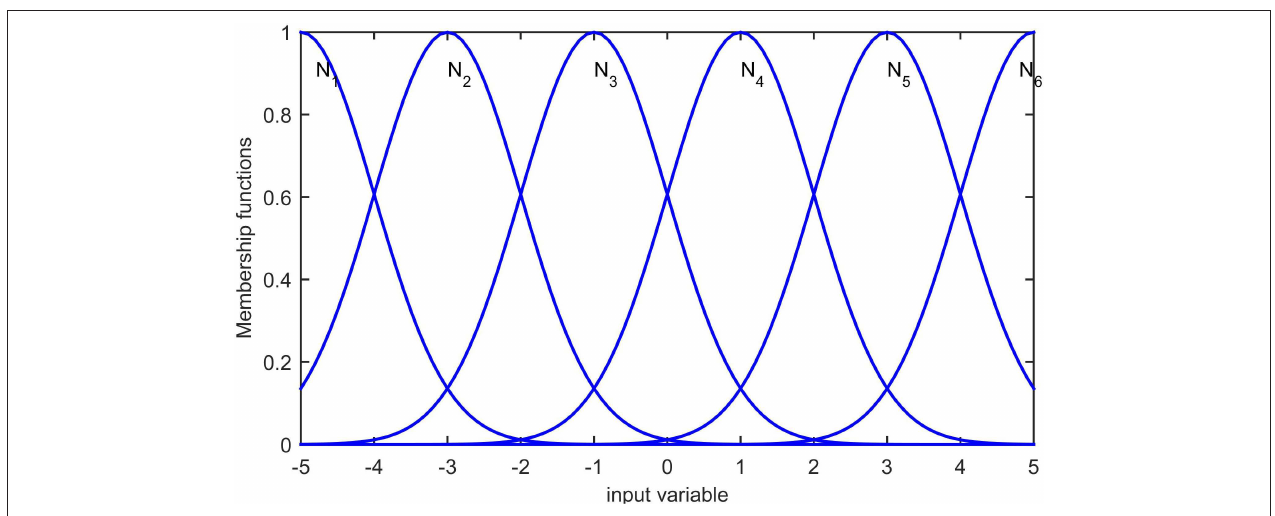
FIGURE 2 | The radial basis functions for